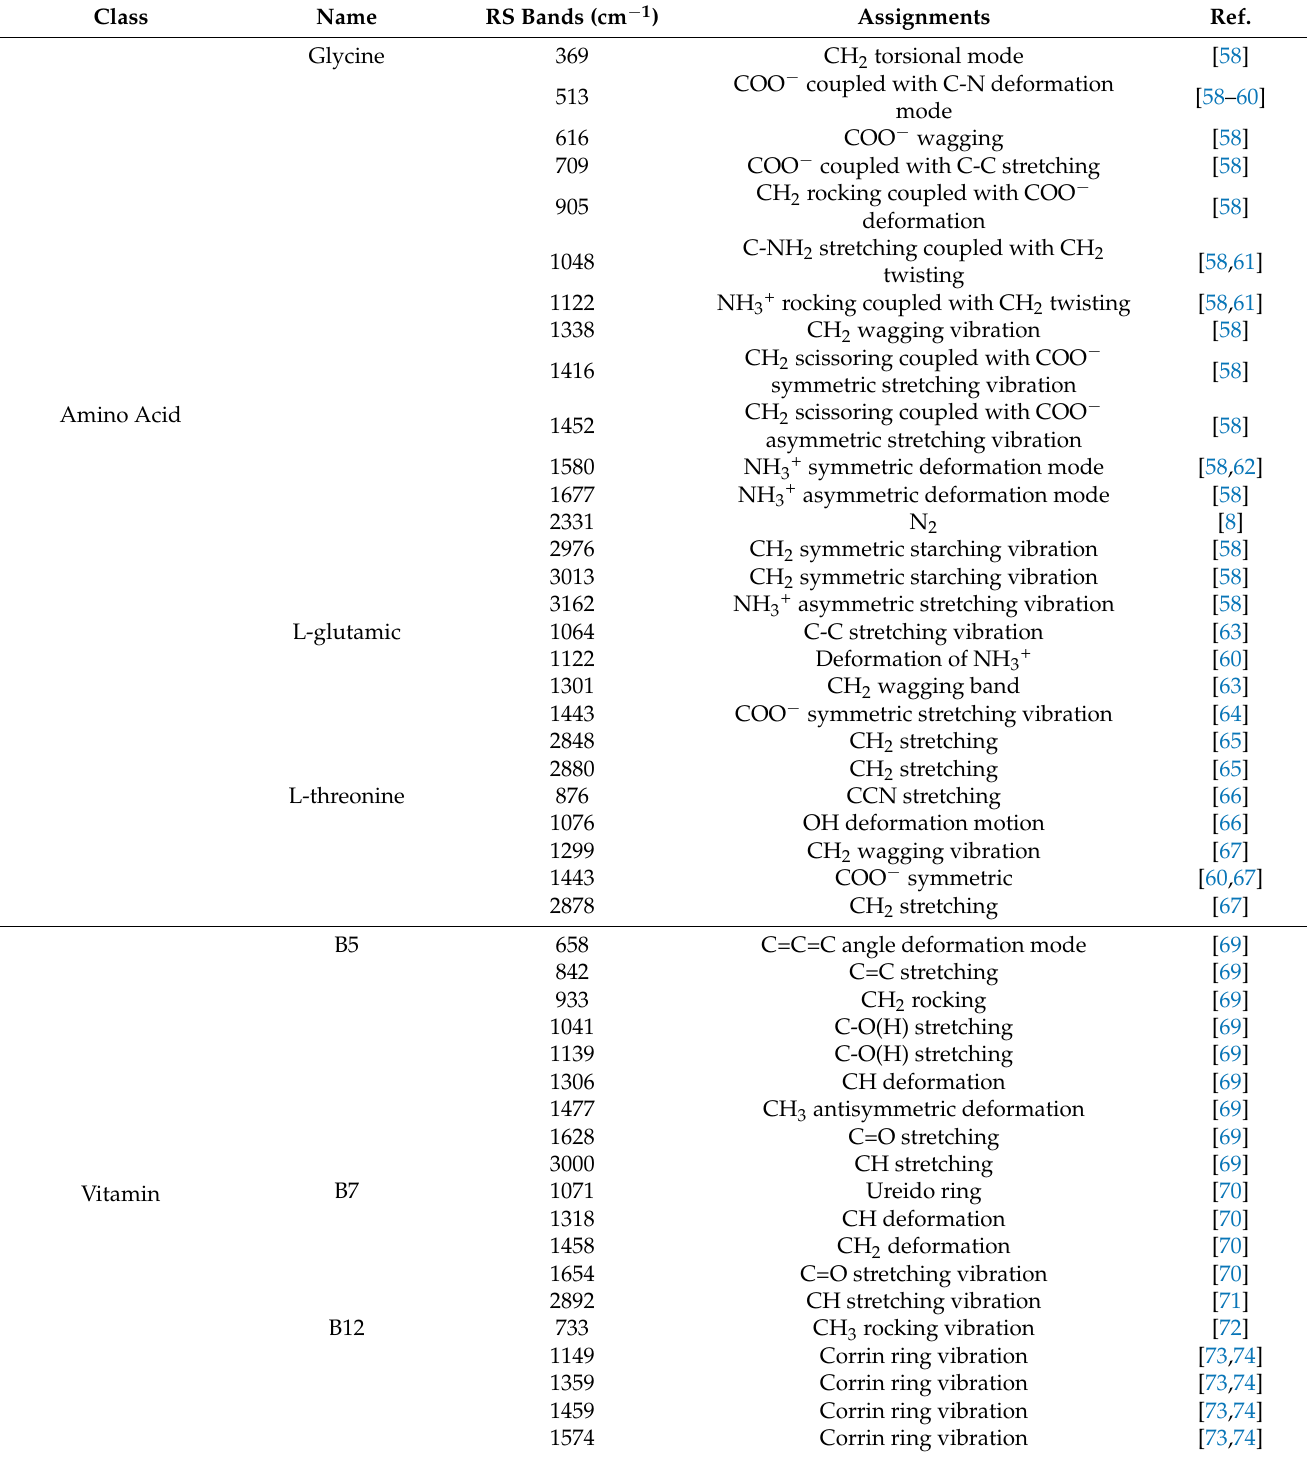
Table 2. A collection of Raman spectral fingerprints from single particles optically trapped in